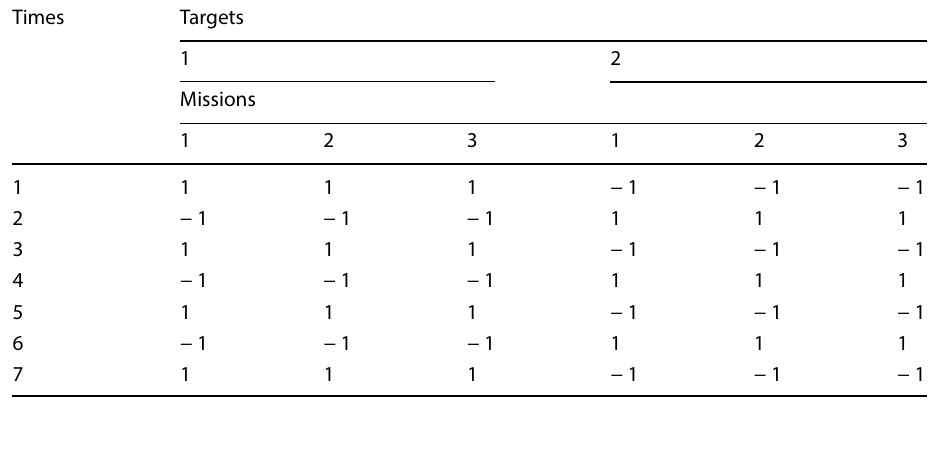
Table 4 Scheduling the activation of a sensor i for each face f of a mission